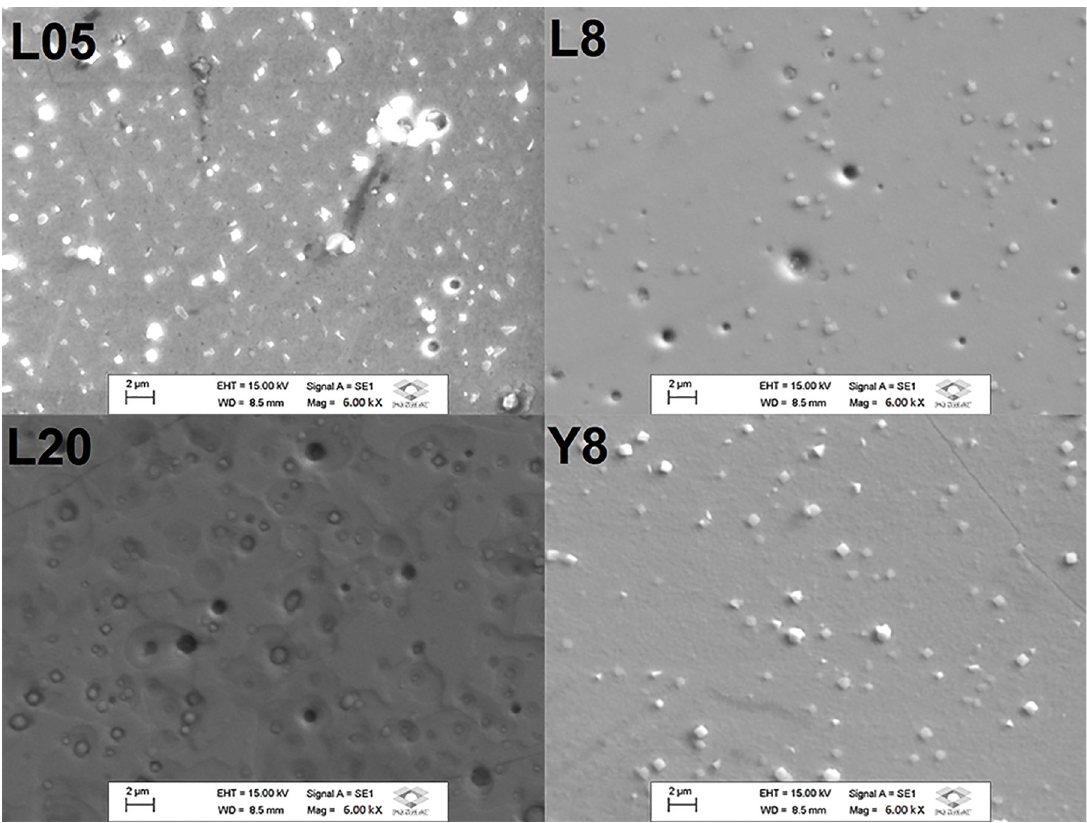
Figure 5. SEM micrographs of the surface of the superlattices (6,000 x